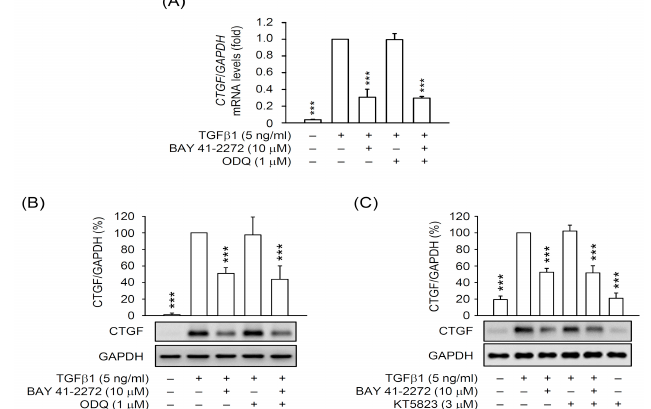
Figure 3. The inhibitory effect of BAY 41-2272 on CTGF expression was independent of the sGC pathway in TGF β 1-activated HSCs. HSCs were pretreated with or without ODQ (1 μ M) or KT5823 (cGMP-dependent protein kinase (PKG) inhibitor) (3 μ M) PKG inhibitors for 15 min. HSCs were sequentially incubated with BAY 41-2272 (10 μ M) for 30 min before activation by TGF β 1 (5 ng/mL) for another 6 h. (A) mRNA levels of CTGF or GAPDH were determined by quantitative RT-PCR. ( B , C ) Expressed CTGF and GAPDH proteins were determined by Western blot using the corresponding antibodies. All data are expressed as mean ± SD ( n = 3). *** p < 0.001 compared with the TGF β 1 alone.